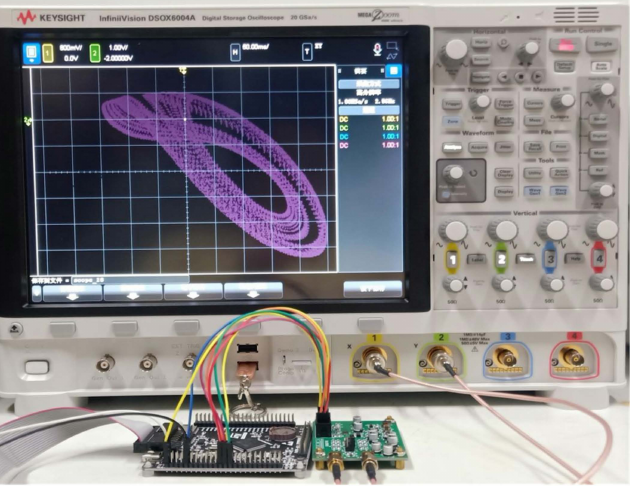
Figure 11. The digitally circuit-implemented hardware platform for the 5-D TMJ system and the induced attractor acquired by the digital oscilloscope.